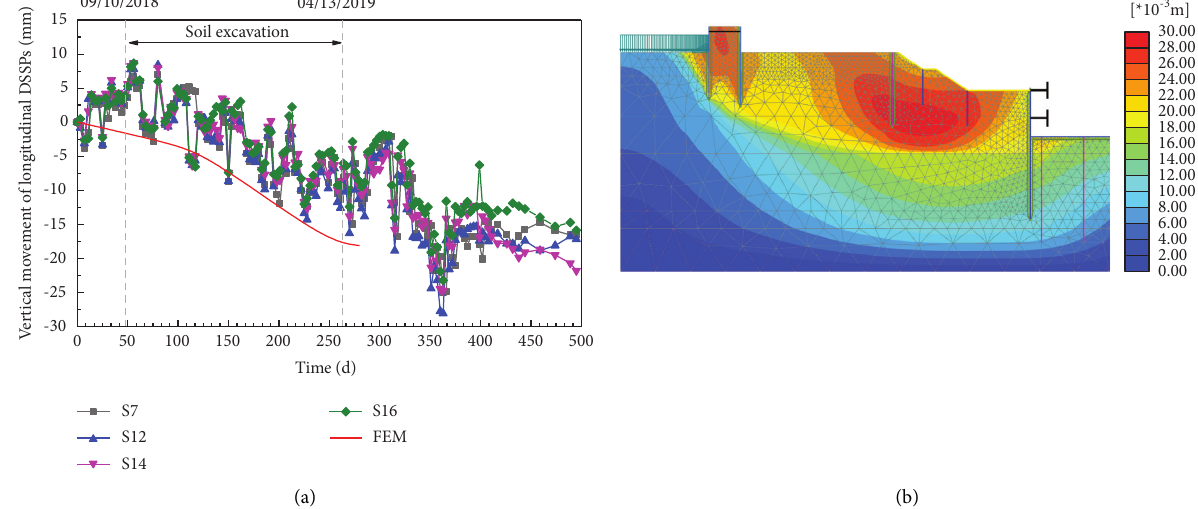
Figure 21: (a) Comparison of the vertical movements of DSSPs between FEM and measurements and (b) lateral soil movements of the foundation pit at Stage 3(a) calculated with the